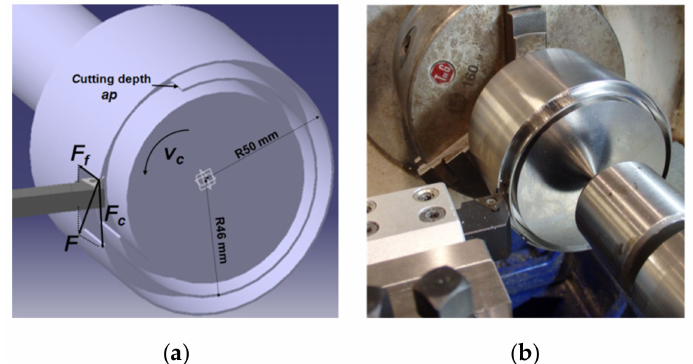
Figure 1. ( a ) Schematic orthogonal cutting; ( b ) tailor-made test specimen geometry.